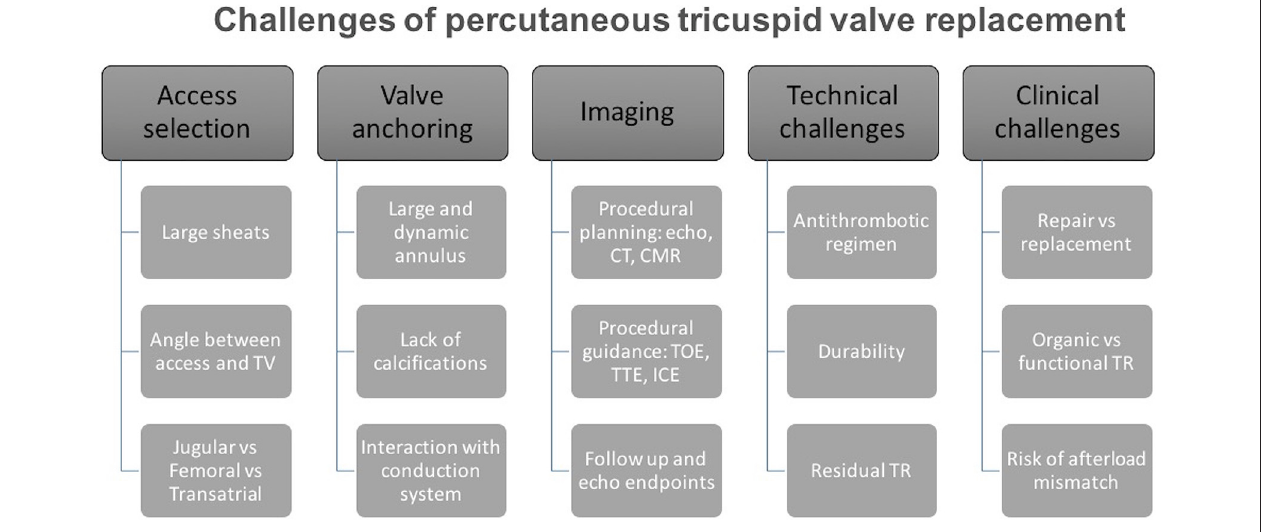
FIGURE 1 | Challenges of percutaneous tricuspid valve replacement. Systematic diagram outlining main challenges that will be encountered during percutaneous tricuspid valve replacement.